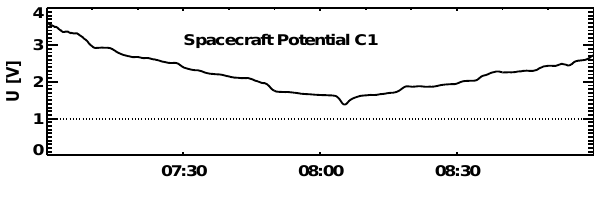
Fig. 2. Spacecraft potential measured by Cluster spacecraft C1. Values of U< 1V (dotted line) are expected inside the plasmas-